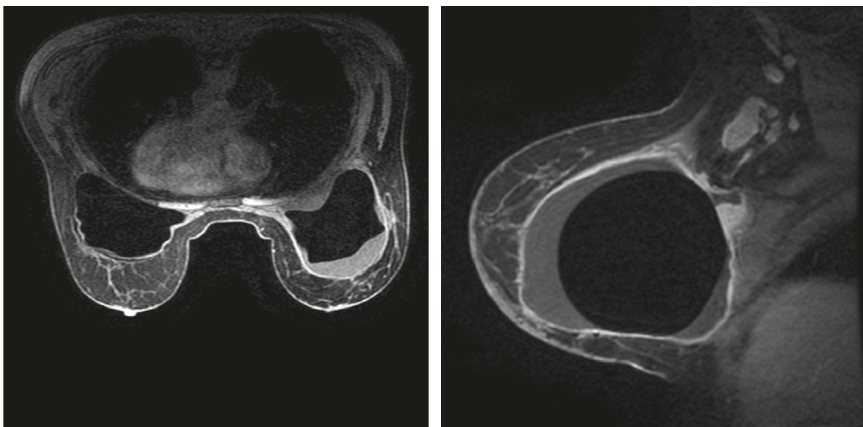
Figure 1: MRI at diagnosis showing fluid surrounding right breast implant, enlarged right axillary lymph